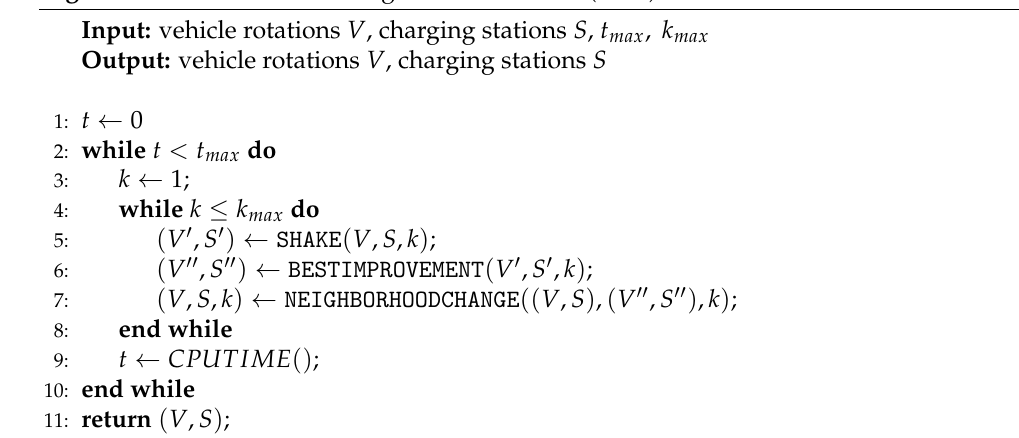
Algorithm 3 Basic Variable Neighborhood Search ( BVNS